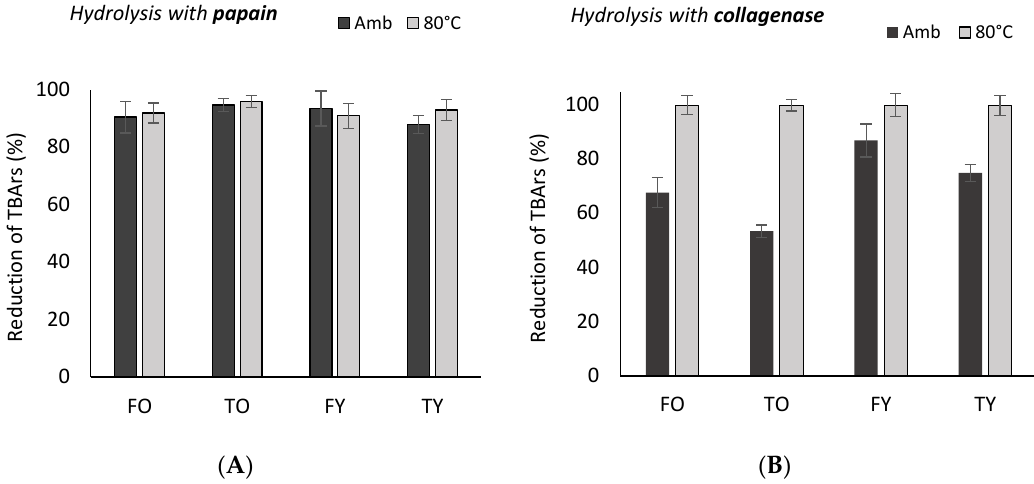
Figure 7. Reduction of TBArs (%) in bovine meat (semimembranosus muscle) at ambient temperature and at 80°C through the addiction of collagen peptides solutions (< 3000 Da) from young and old bovine femur and tibia obtained through the enzymes papain ( A ) and collagenase ( B ). FO = old femur, 10 years; TO = old tibia, 10 years; FY = young femur, 4.5 years; TY = young tibia, 4.5 years. Table 5. Reduction of TBArs (%) in 22.5 mg of meat lipids (i.e., 1 g of raw meat), per mg of collagen peptides, at ambient temperature. FO = old femur, 10 years; TO = old tibia, 10 years; FY = young femur, 4.5 years; TY = young tibia, 4.5 years. Alcalase Collagenase Esperase Neutrase Papain Savinase